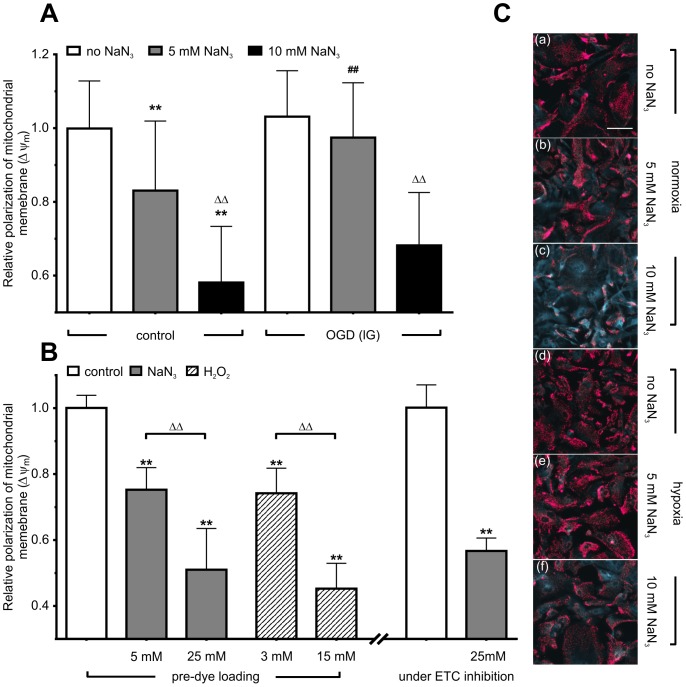
OGD in lG partly preserves Δψm (i.e. delays depolarization) caused by subsequent NaN3 treatment.(A) Sodium azide (NaN3) causes concentration-dependent decline of Δψm in both experimental conditions. However, OGD in lG medium significantly delayed the decrease in JC-1 fluorescence ratio caused by treatment with 5 mM NaN3 during simulated reperfusion. (B) Expectedly, both NaN3 and H2O2 show concentration-dependent effect by lowering the JC-1 red/green fluorescence ratio. Astrocytes were stained with JC-1 either before or during the treatment with NaN3 (marked as pre-dye loading and dye loading under ETC inhibition, respectively). NaN3 has not affected the cell membrane organization allowing at the same time JC-1 to enter the cytoplasm and mitochondria within. (C) Representative fluorescent micrographs of astrocytes labeled with JC-1 Original micrographs were converted to tritanope color palette (ImageJ 1.48a). Depolarization is visible in the normoxic group (b, c) (seen as concentration-dependent decrease in magenta and increase in blue color), but it is more pronounced than in OGD group after treatment with NaN3 (e, f). Some mitochondria remained partly depolarized. Data are expressed as a percentage normalized to the red/green fluorescence ratio values of untreated control (the first bar from left). Significant differences are indicated by **p<0.01 with respect to untreated control, ##p<0.01 between treatment and its respective control, ΔΔp<0.01 between different inhibitor concentrations.